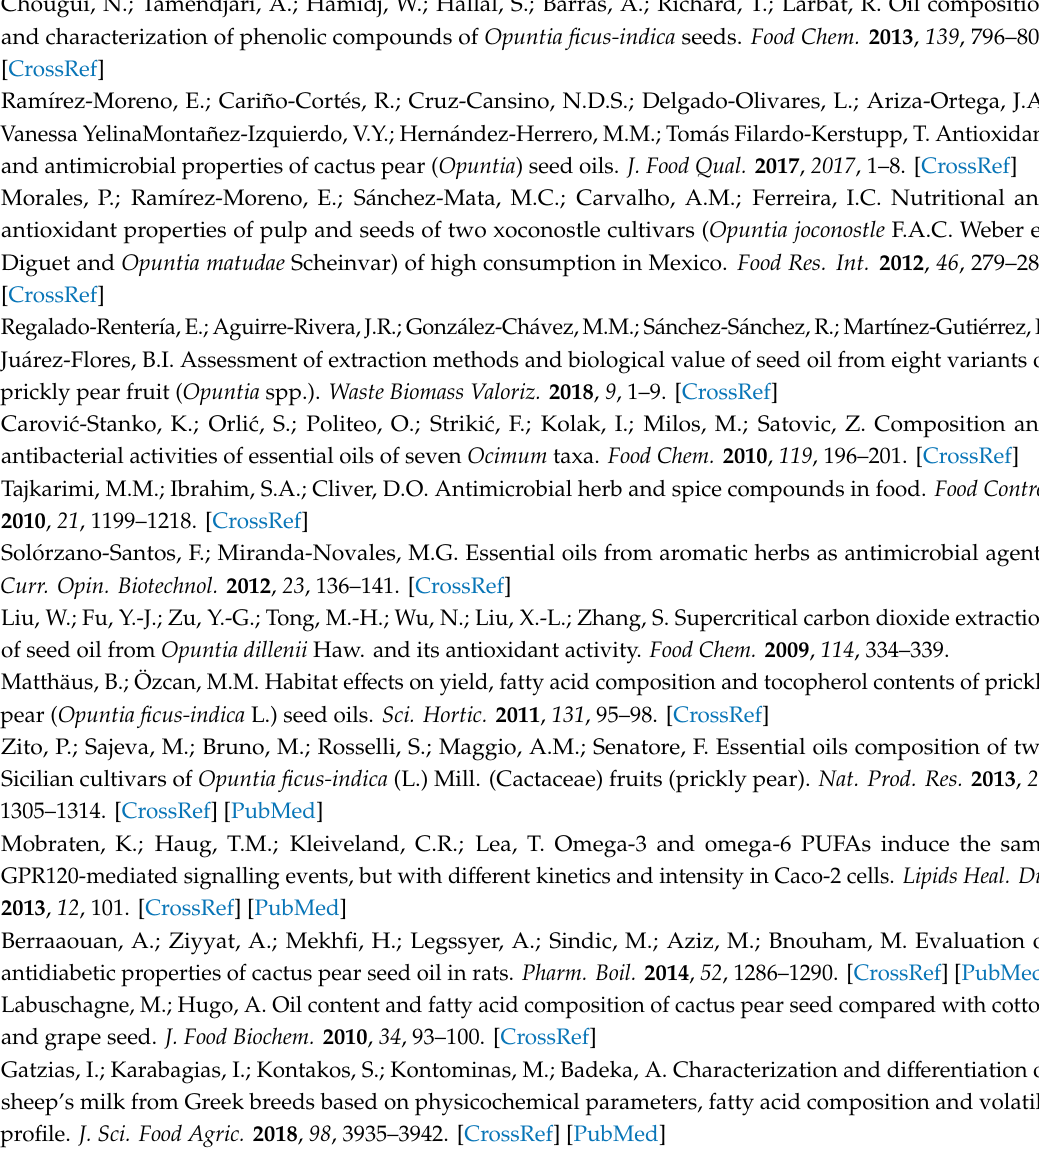
Table S1: Volatile compounds of PPSO tentatively identified using HS-SPME / GC-MS and NIST MS 11 mass spectral